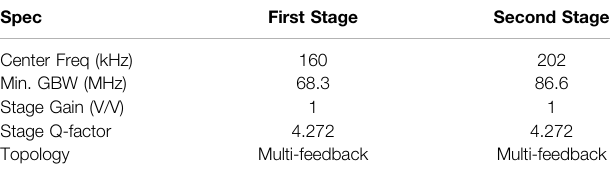
TABLE 3 | Bandpass fi lter speci fi cations.